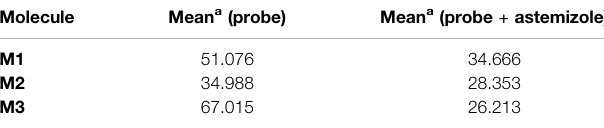
TABLE 4 | Fluorescence intensity of cell imaging.